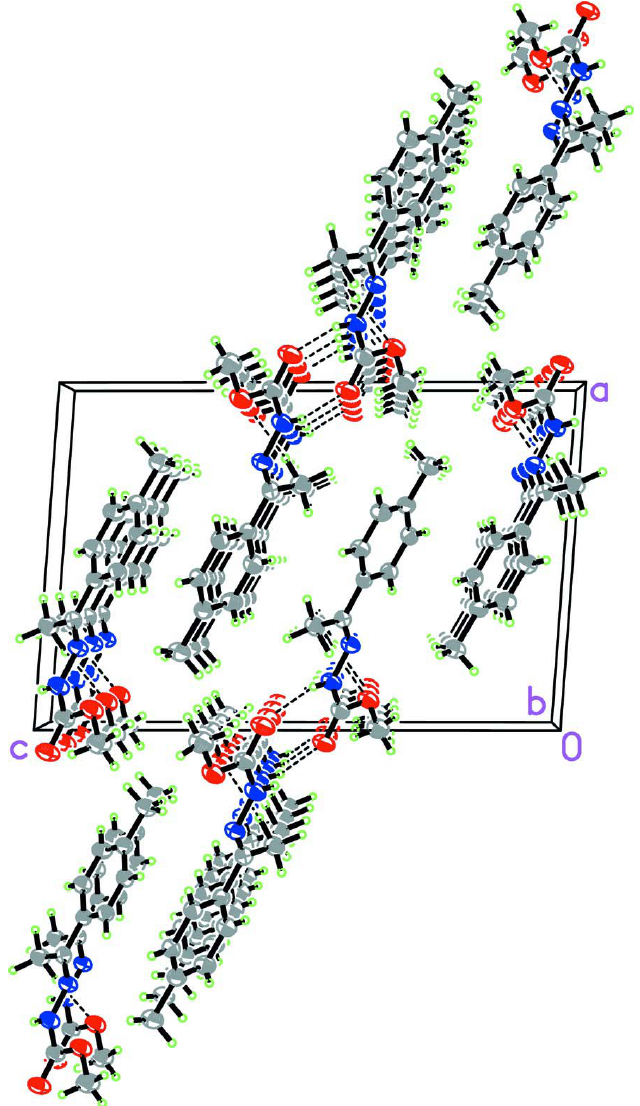
A packing diagram of the title compound. Hydrogen bonds are shown as dashed